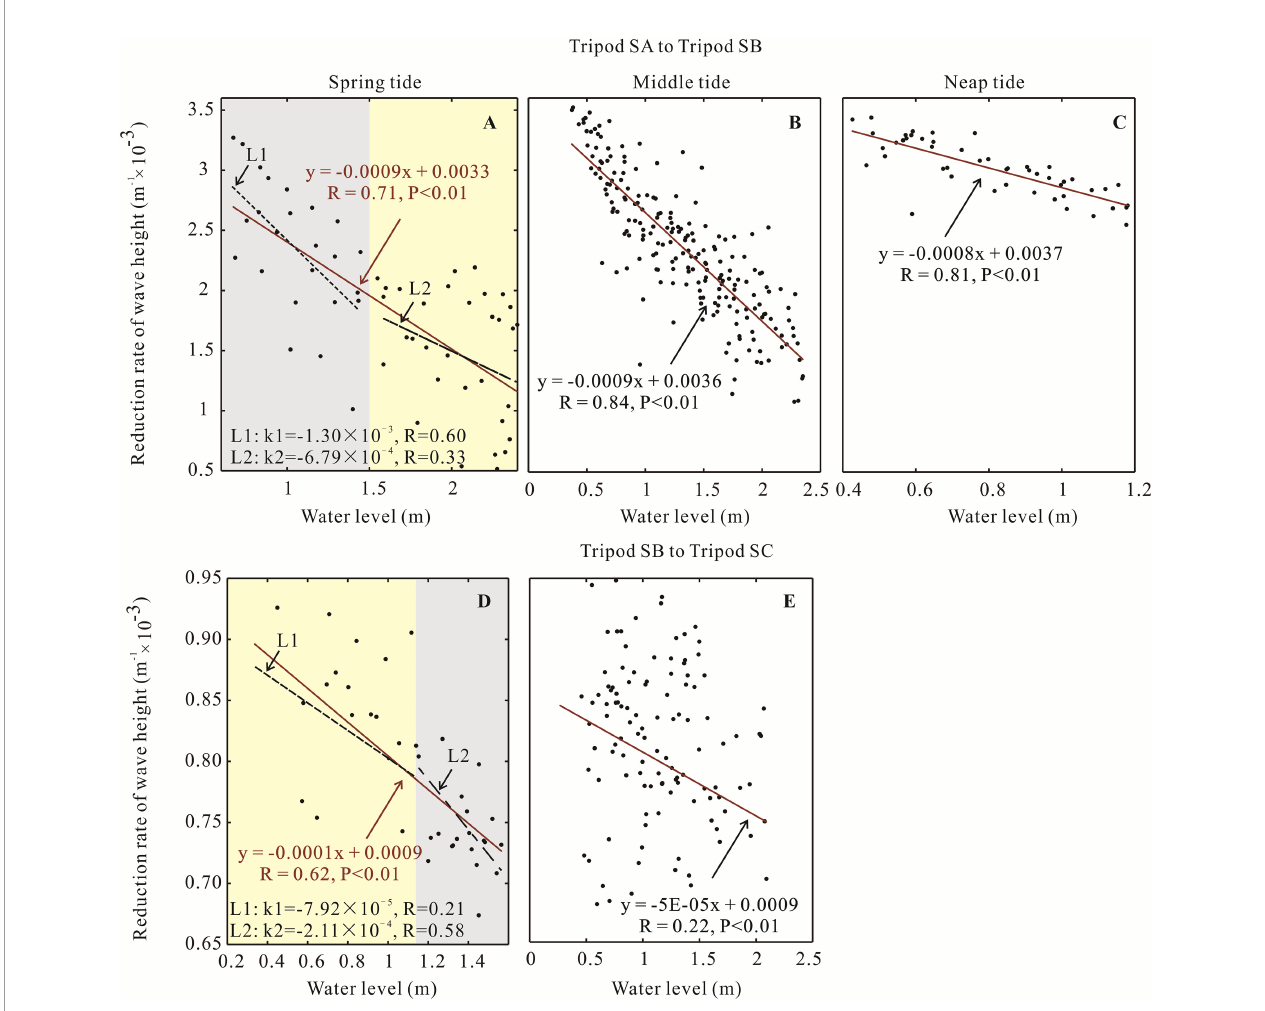
FIGURE 9 | Relationship between the water level and wave height reduction rate shown along the transect from tripod SA to SB (A – C) and tripod SB to SC (D, E) during spring to neap tides. Black dots are the measured data, and red lines are the linear fi tted relationship. Gray and yellow shadows in (A, D) represent the periods of high and low attenuation reduction rates,